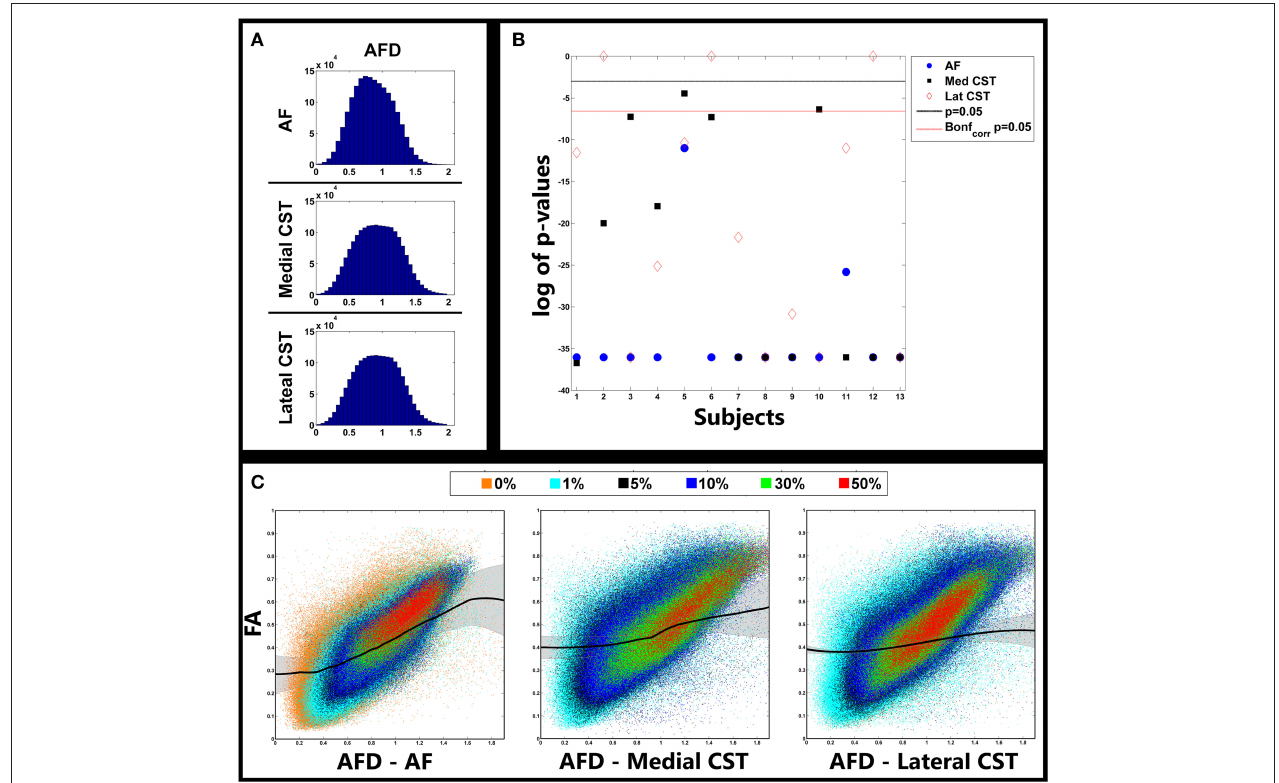
FIGURE 4 | Relationship between AFD and FA. (A) Distribution of AFD gathered from fiber pathways investigated in all subjects. (B) (uncorrected) p -values of model selection tests between cubic and linear fits of FA vs. AFD curves for each subject and pathway. Lines represent type I error level of 0.05 both uncorrected (black) and corrected (red dotted) for multiple comparisons via Bonferroni correction. Significant values indicate that cubic fit outperformed linear one. (C) Scatterplots showing relationship between AFD and FA. Colors represent different cutoff levels. Black lines represent cubic fit averaged over all subjects. Shaded lines represent standard deviations. AFD, Apparent Fiber Density; AF, Arcuate Fasciculus; CST, Corticospinal